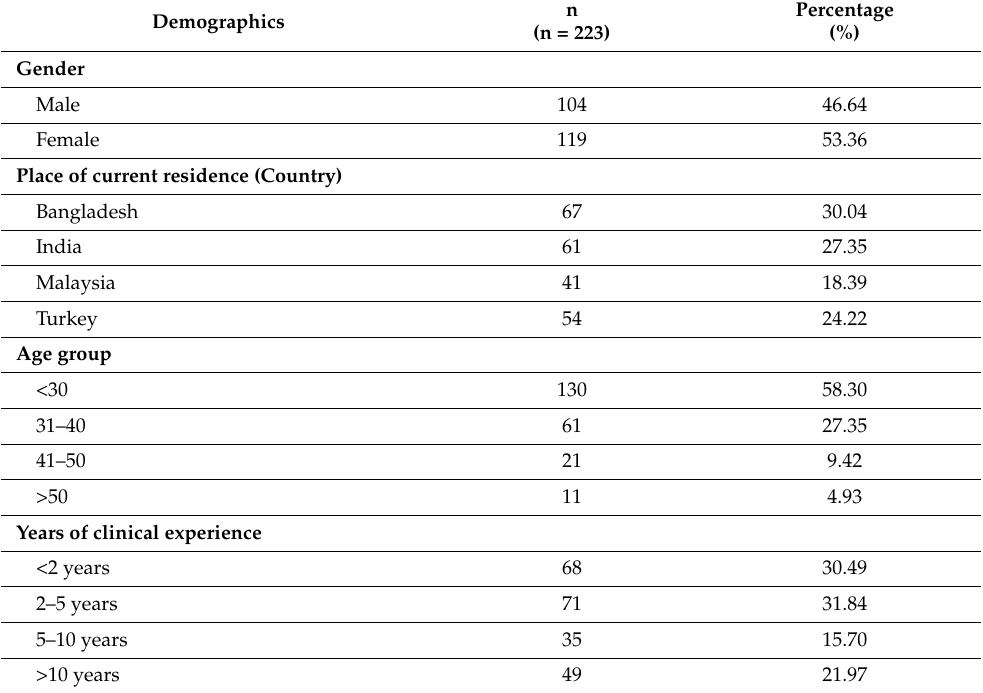
Table 1. Socio-demographic characteristics of the study population.